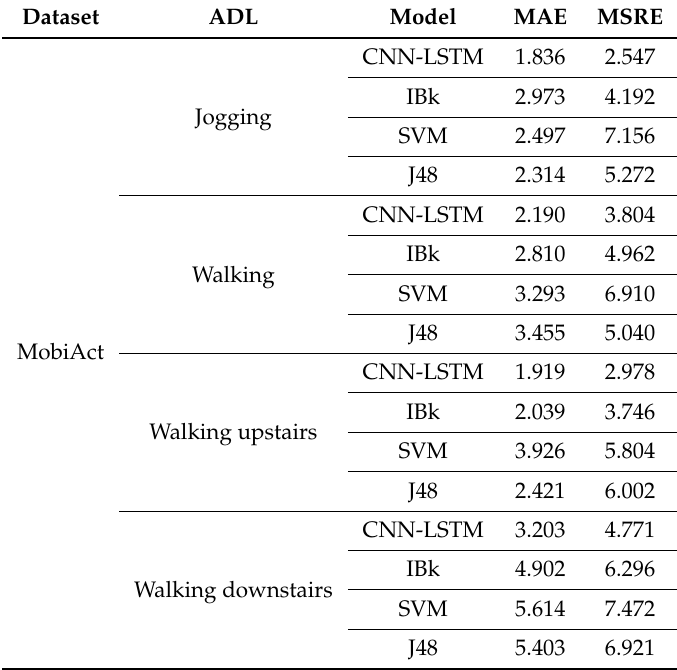
Table 3. The experimental results in MobiAct without data